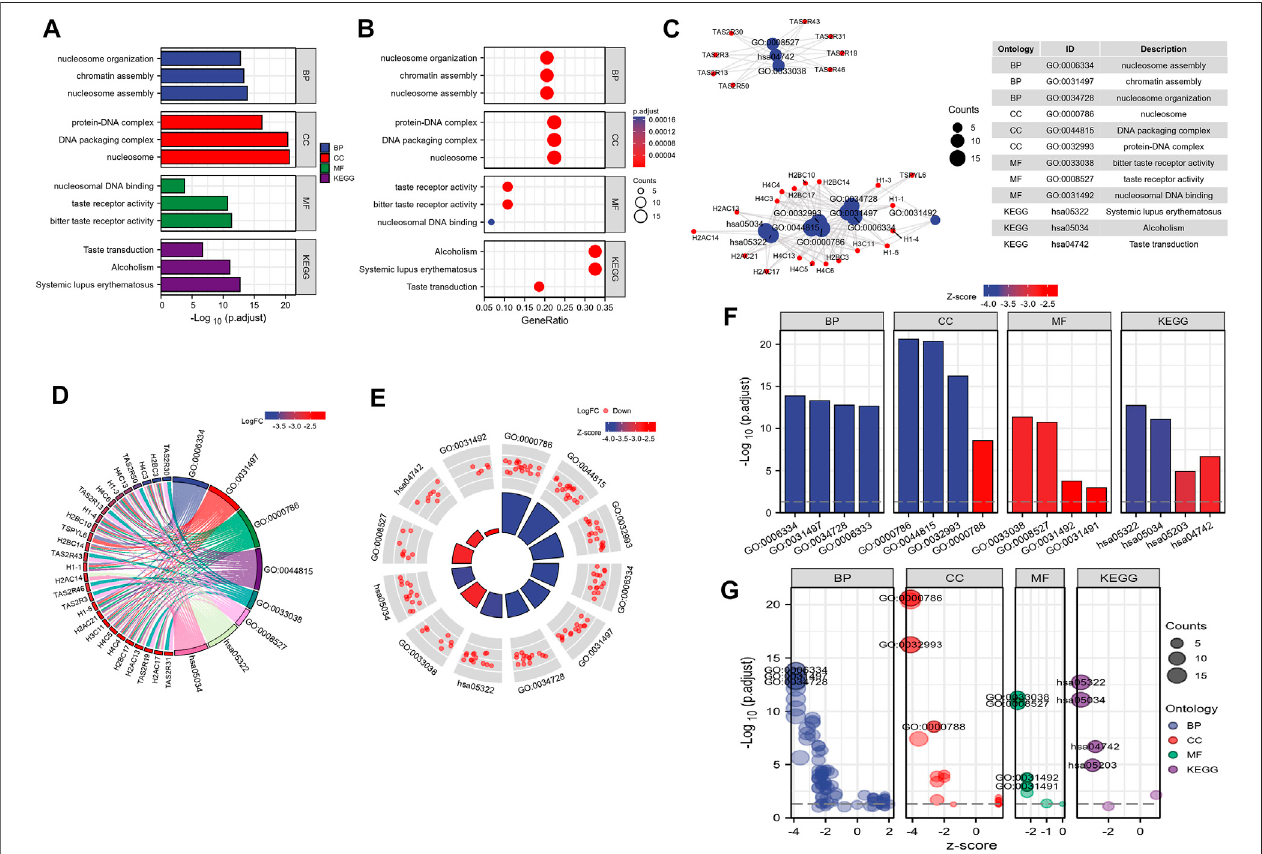
FIGURE7| FJX1-relatedbiologicalpathways. (A – C) GOpathway-enrichedbiologicalentriesandKEGGpathway-enrichedbiologicalentrieswereobtained. (D – G) The z-scores for these entries were all negative, implying that these pathways may be inhibited.